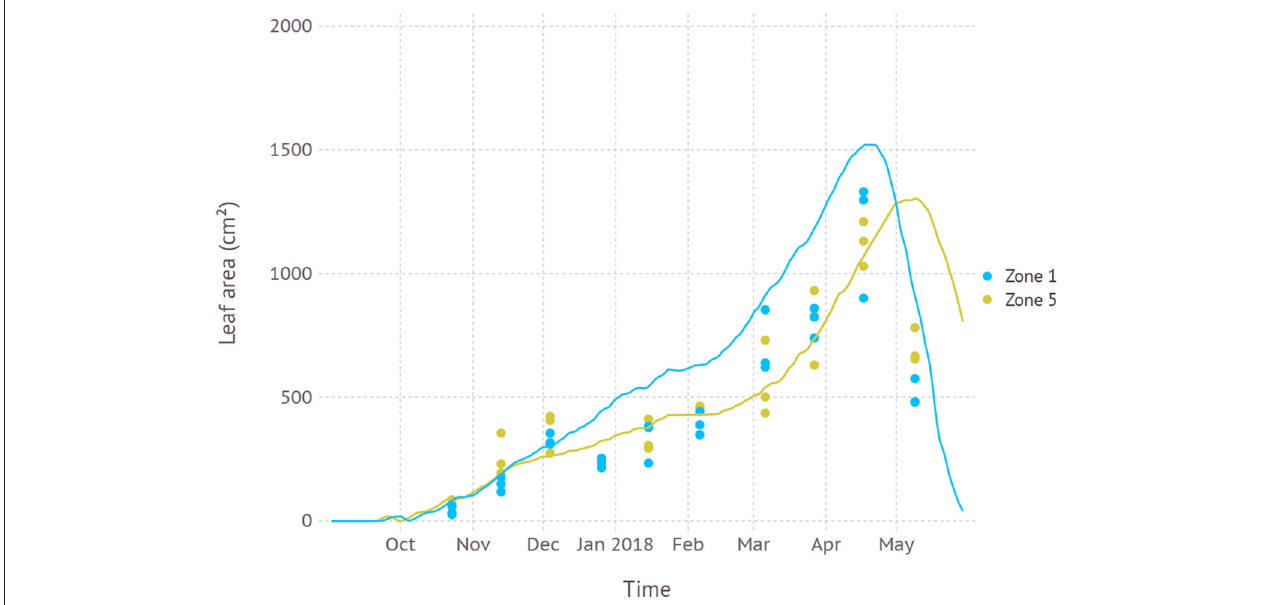
FIGURE 7 | Comparison of model simulated green leaf area and observation for two temperature zones (Zone 1: high, Zone 5: low) recorded in dataset D2 from a temperature-controlled glass house.